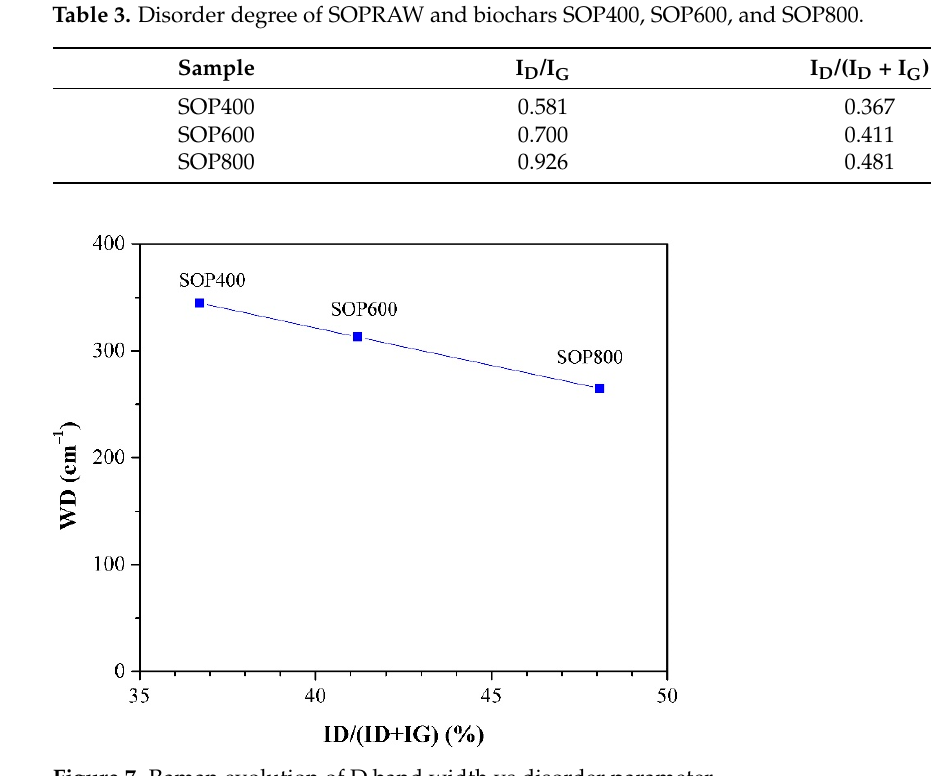
Figure 7. Raman evolution of D band width vs disorder parameter.